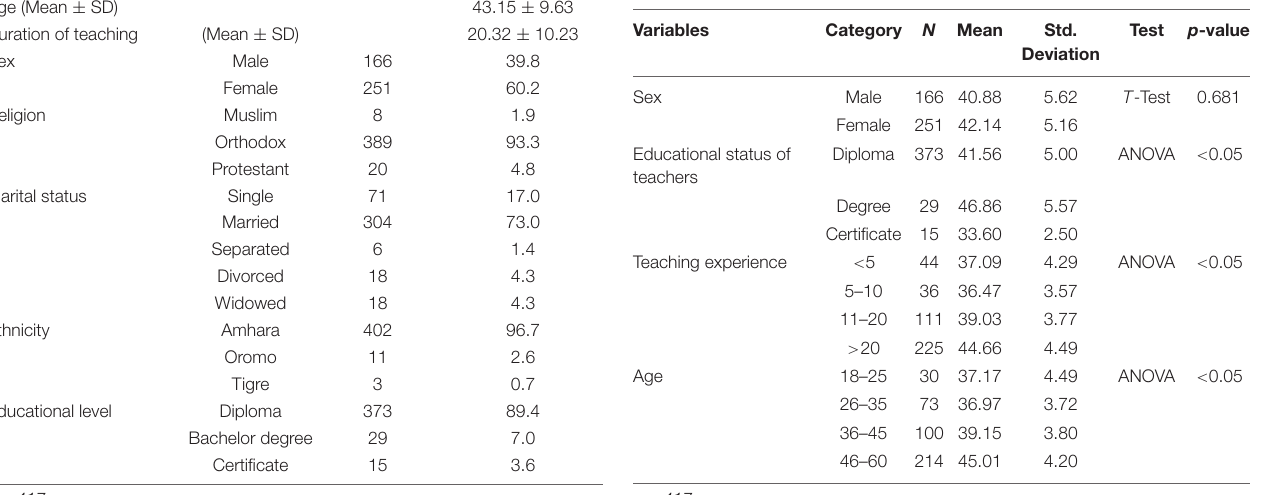
TABLE 3 | Comparation of mean score of attitudes of primary school teachers by socio-demographic variables in Debre Markos and Dejen towns,